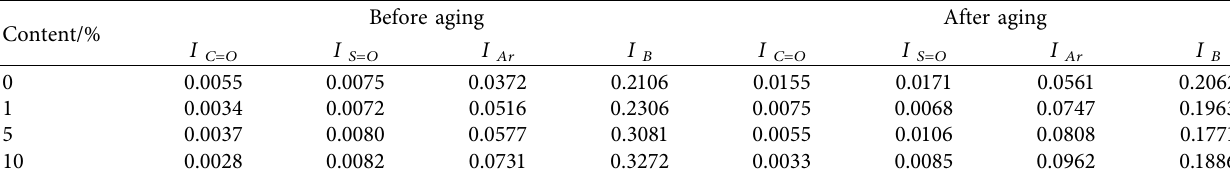
Table 8: Effect of Irgafos 168 on the functional group index of 2#.